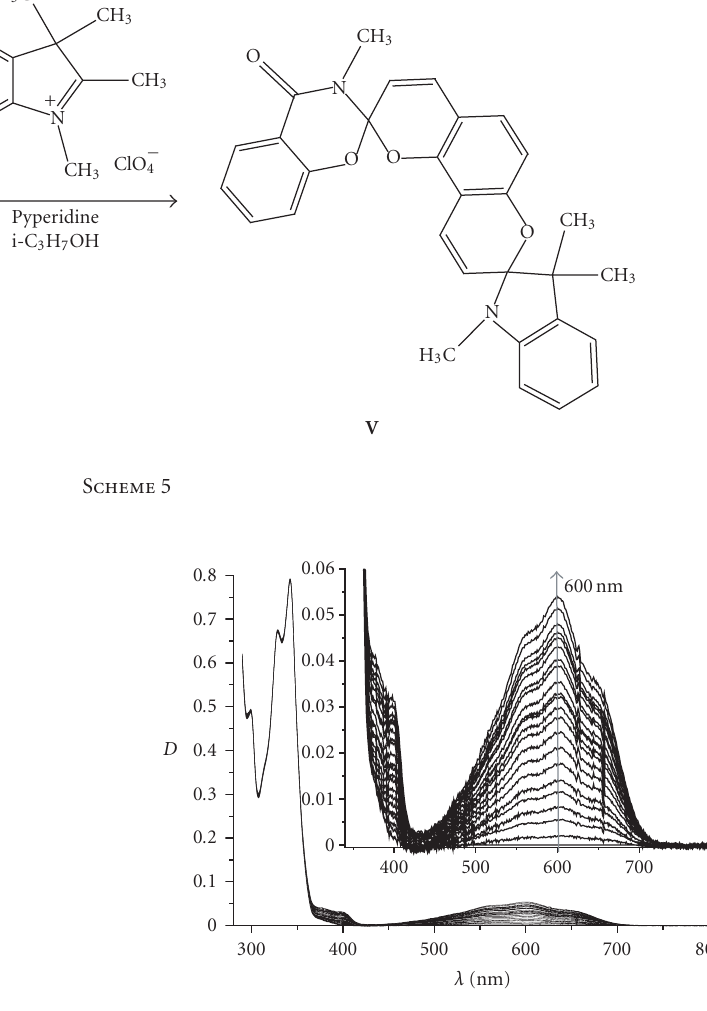
Figure 3: Absorption spectra of spiropyran VI (b) in toluene at t = 10 ◦ C: (a) before irradiation; (b) after irradiation with UV light λ = max